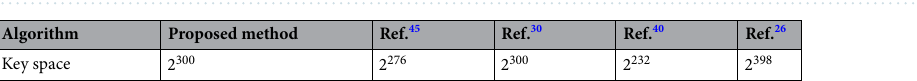
Table 5. Key space of the proposed method and other approaches.